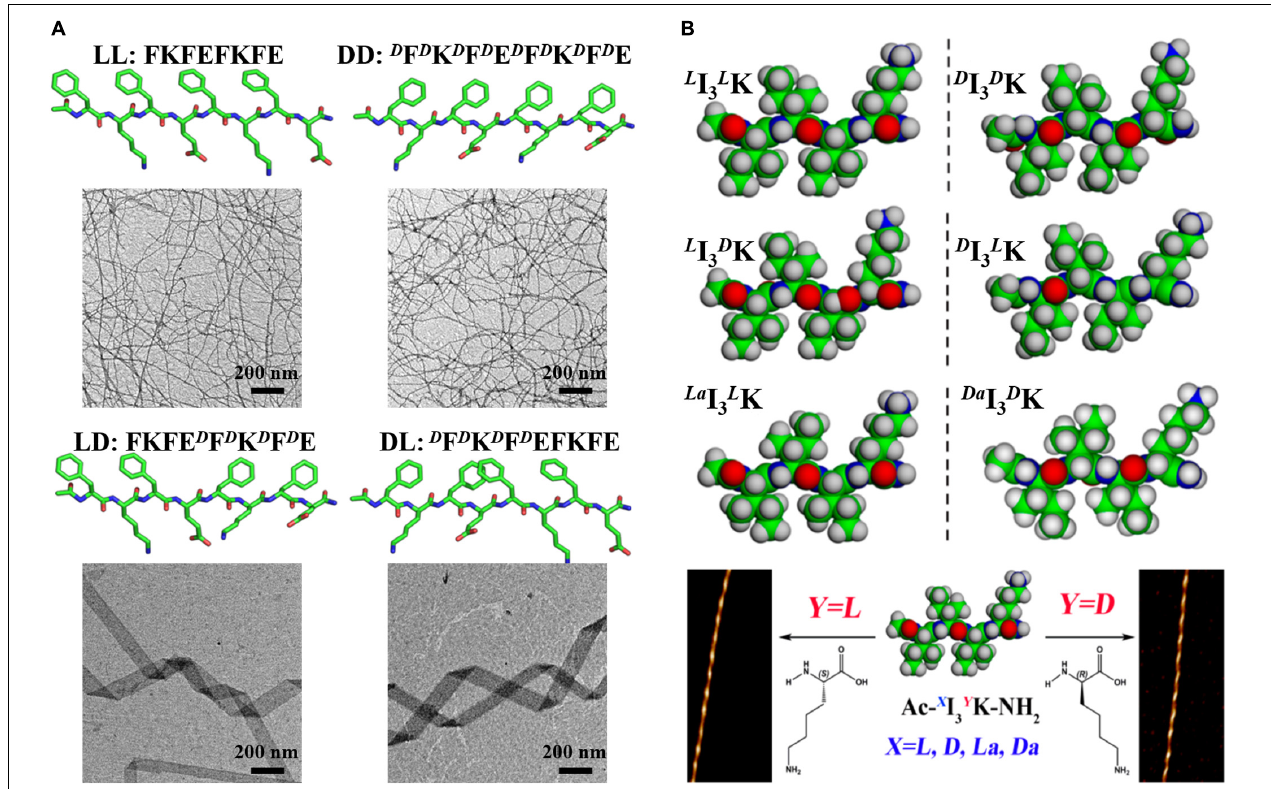
FIGURE 1 | The effects of amino acid chirality alteration on peptide assembly structure. (A) Amino acid chirality alteration drastically changes the morphology of assembly structure of the peptide Ac-(FKFE) 2 -NH 2 . Reproduced with permission from Clover et al. (2020). Copyright 2020 American Chemical Society. (B) The handedness of fibers formed by I 3 K is controlled by the chirality of the C-terminal hydrophilic Lys. Reproduced with permission from Wang M. et al. (2017). Copyright 2017 American Chemical